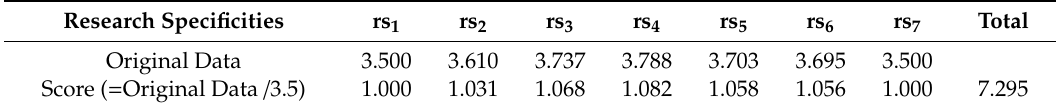
Table 9. Scores of research